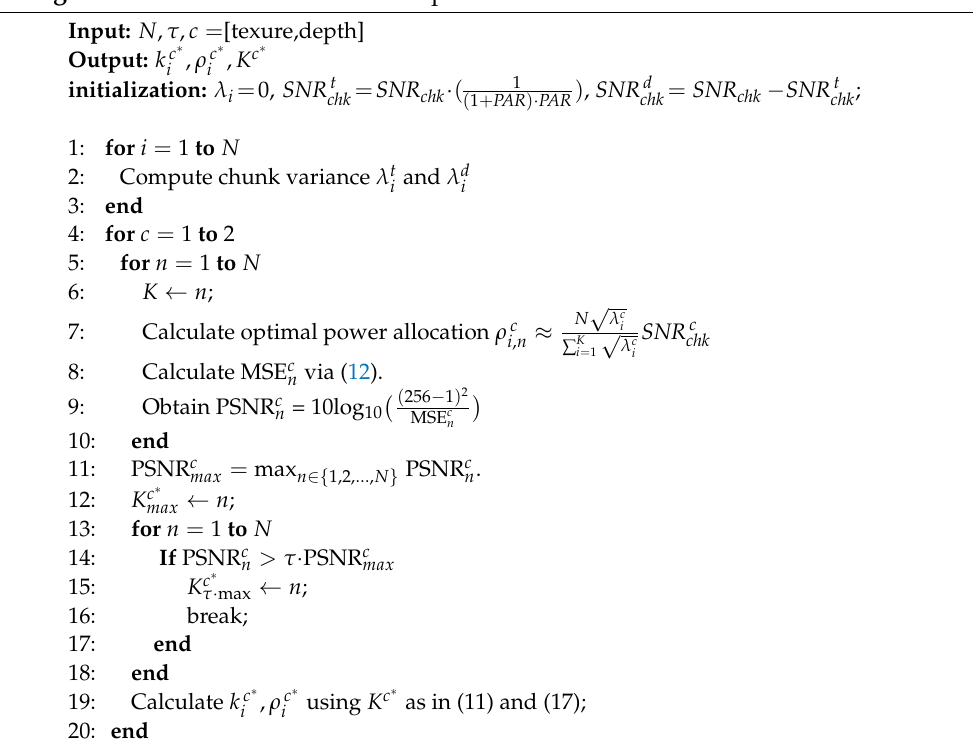
Algorithm 1: Minimum Distortion